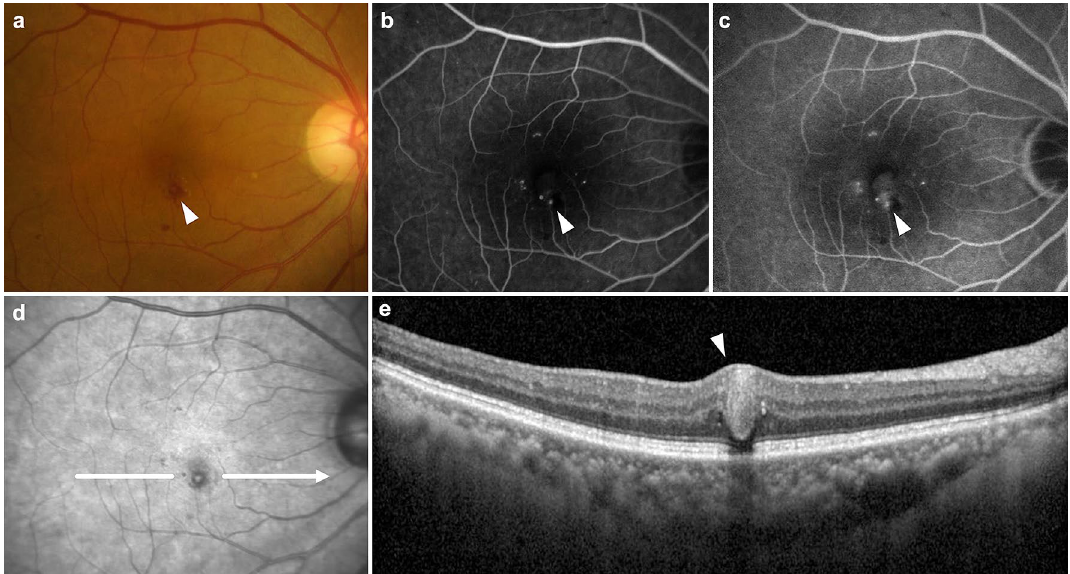
Figure 1. Multimodal imaging of a telangiectatic capillary (TelCap) (arrowhead) in persistent diabetic macular edema. ( a ) Color fundus photo shows intraretinal hemorrhages, microaneurysms, and TelCap with several hard exudates inferior to the fovea. The TelCap appears as a reddish round superficial lesion with a diameter larger than 150 µm. Fluorescein angiography shows multiple hyperfluorescent lesions including microaneurysms and TelCaps in the early phase ( b ) and leakage of TelCaps in the late phase ( c ). ( d ) An infrared reflectance image reveals that the TelCap is characterized by hyperreflectivity inside a hyporeflective spherical lesion, distinguishing it from other microaneurysms. ( e ) Optical coherence tomography shows a hyporeflective ovoid lesion surrounded by a hyperreflective TelCap